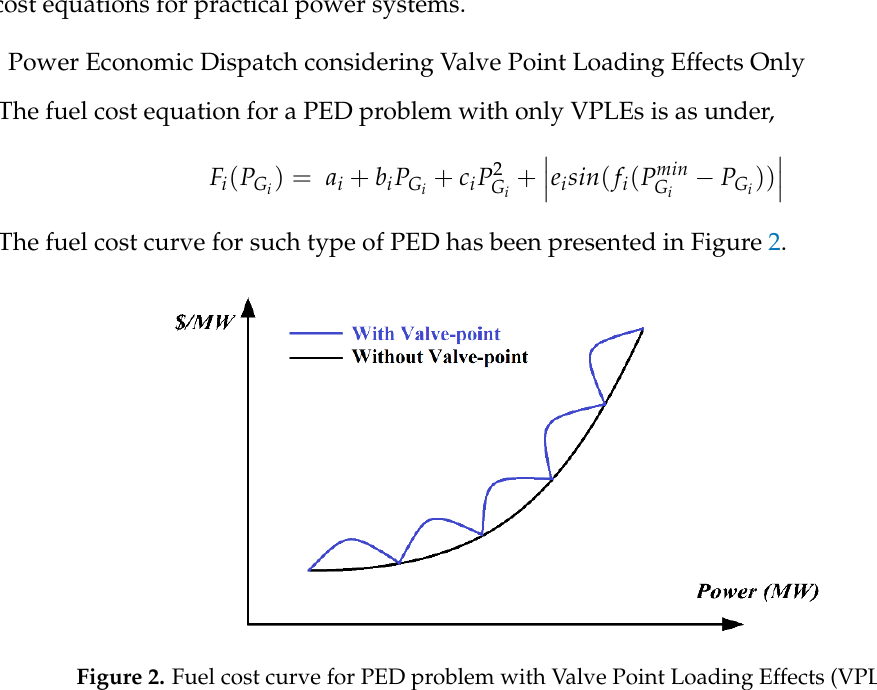
Figure 2. Fuel cost curve for PED problem with Valve Point Loading Effects (VPLEs).